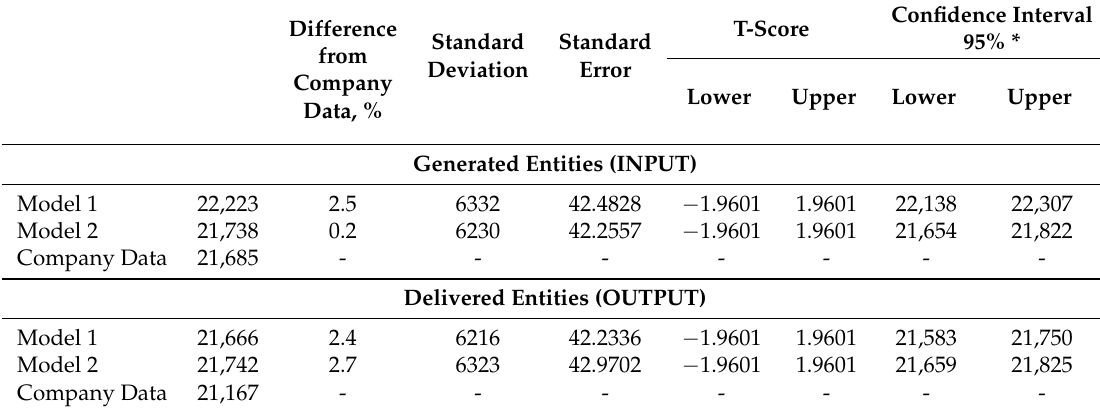
Table 3. Total number of generated and delivered entities over one year period based on 100 simulation runs using models 1 and 2. * Confidence intervals based on the final values of the